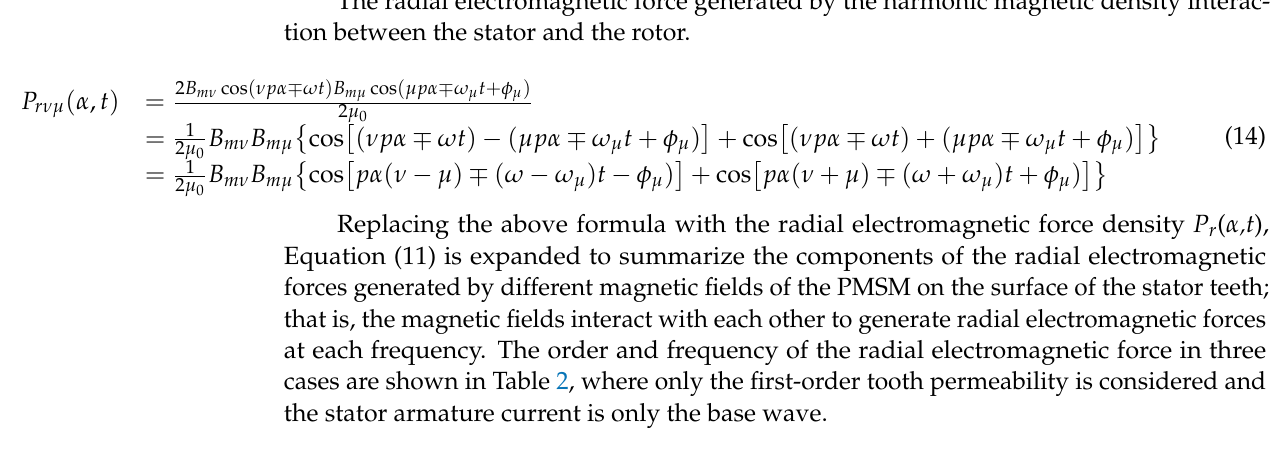
Table 2. The order and frequency of radial electromagnetic